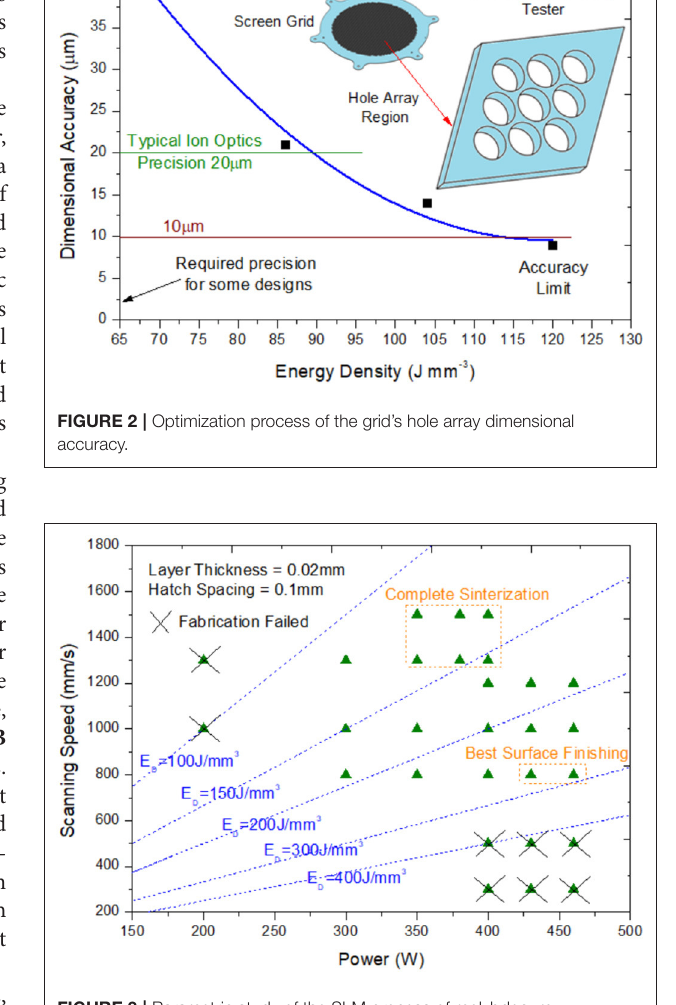
FIGURE 3 | Parametric study of the SLM process of